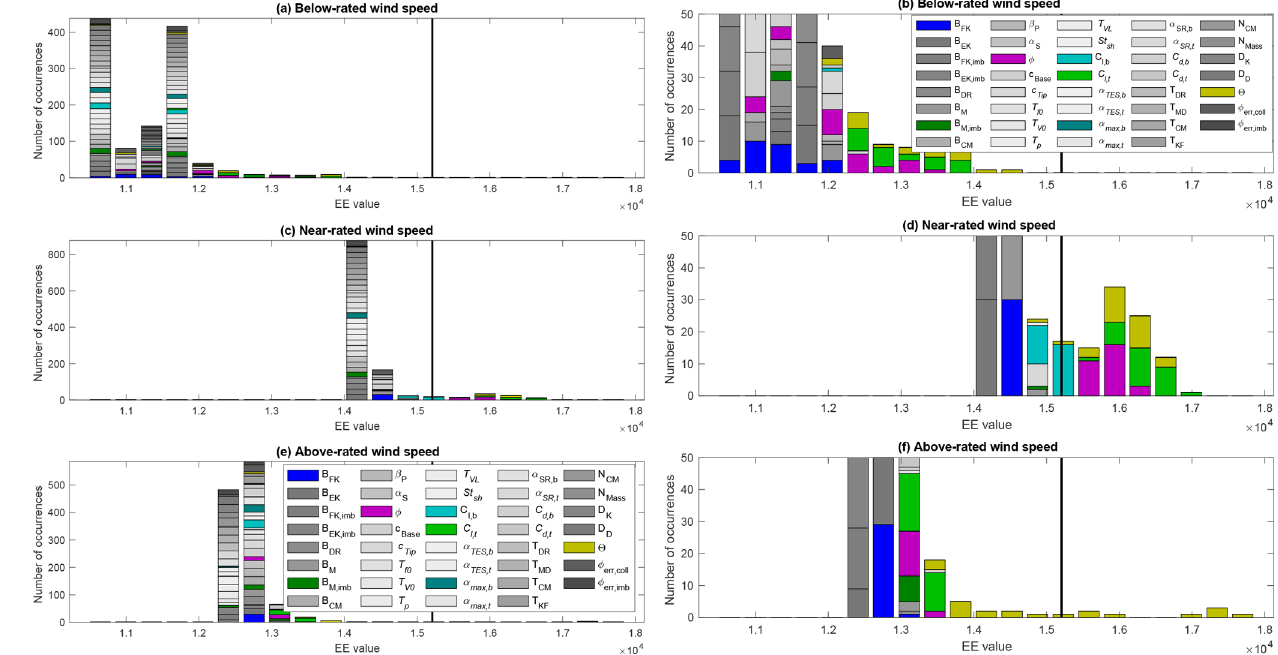
Figure 16. EE-value histograms of blade-root bending ultimate moment. Each graph shows one wind speed bin and includes all input parameters. Right column is a zoomed-in view of the left column.